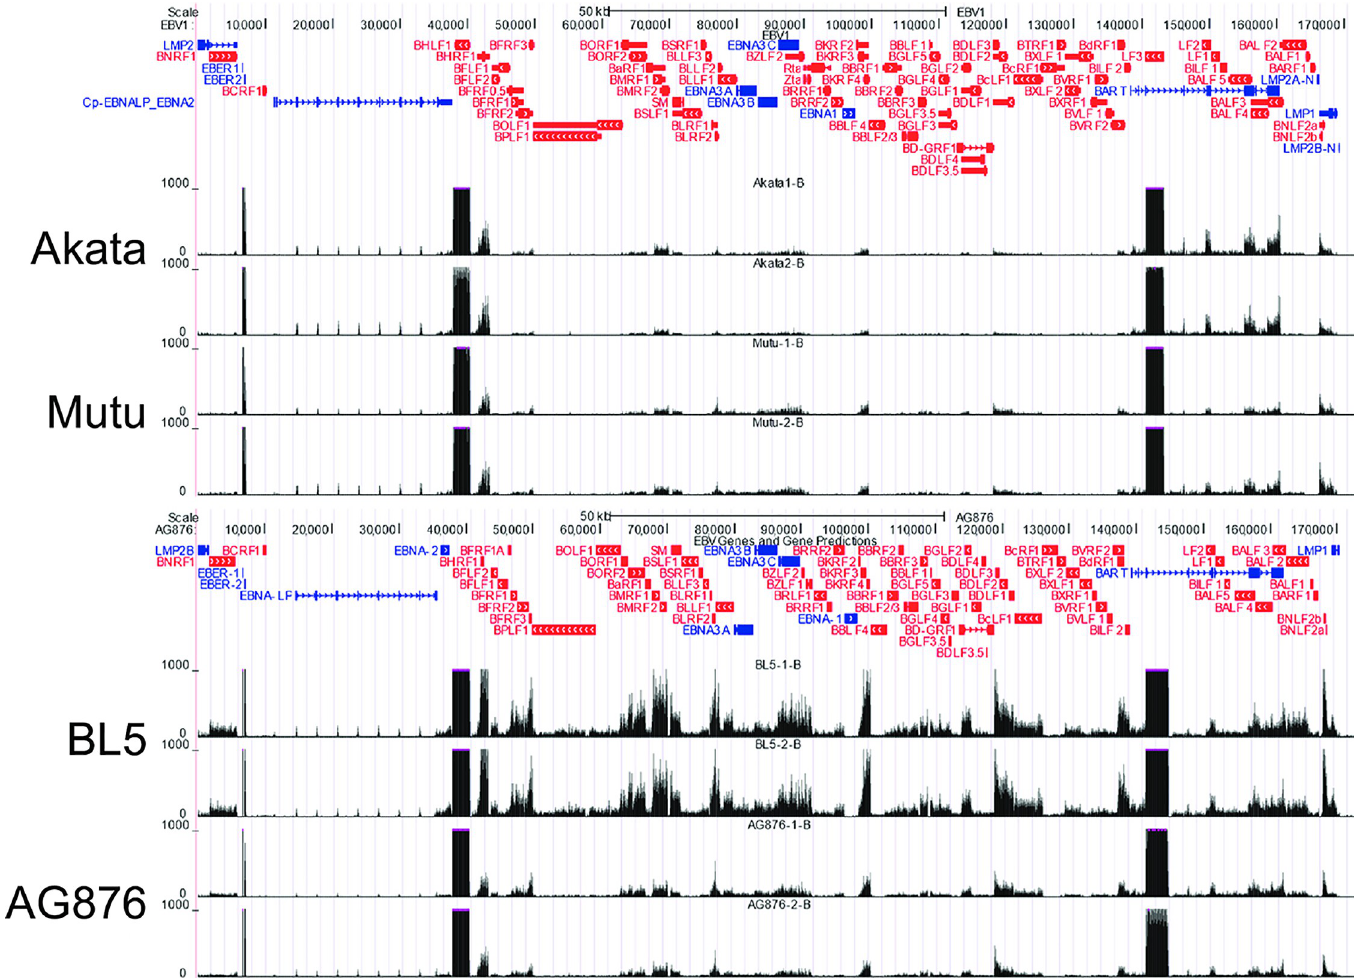
Fig 2. EBV gene expression in T2 virus- versus T1 virus-infected LCLs. RNA-seq reads from LCLs infected with T1 or T2 viruses were aligned to the T1 or T2 EBV genomes, respectively. For each replication, wiggle tracks of normalized read depth are displayed using the UCSC genome browers. Annotation tracks for type 1 and type 2 virues showing latent (blue) genes and lytic (red) genes are displayed